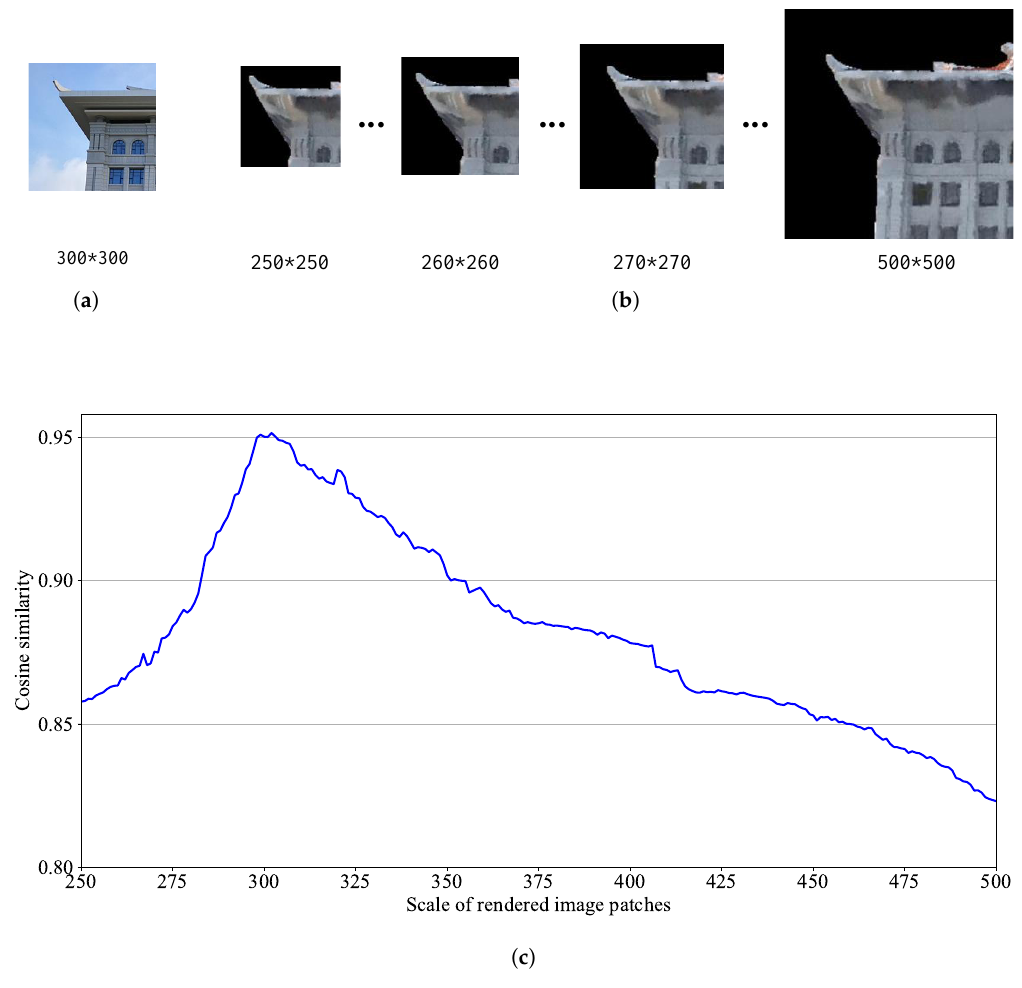
Figure 11. The cosine similarity of varied image patch pairs with different scale. ( a ) Fixed patch. ( b ) Gradually varied rendered image patches with different scale. ( c ) The cosine similarity of ( a ) and each patch in ( b